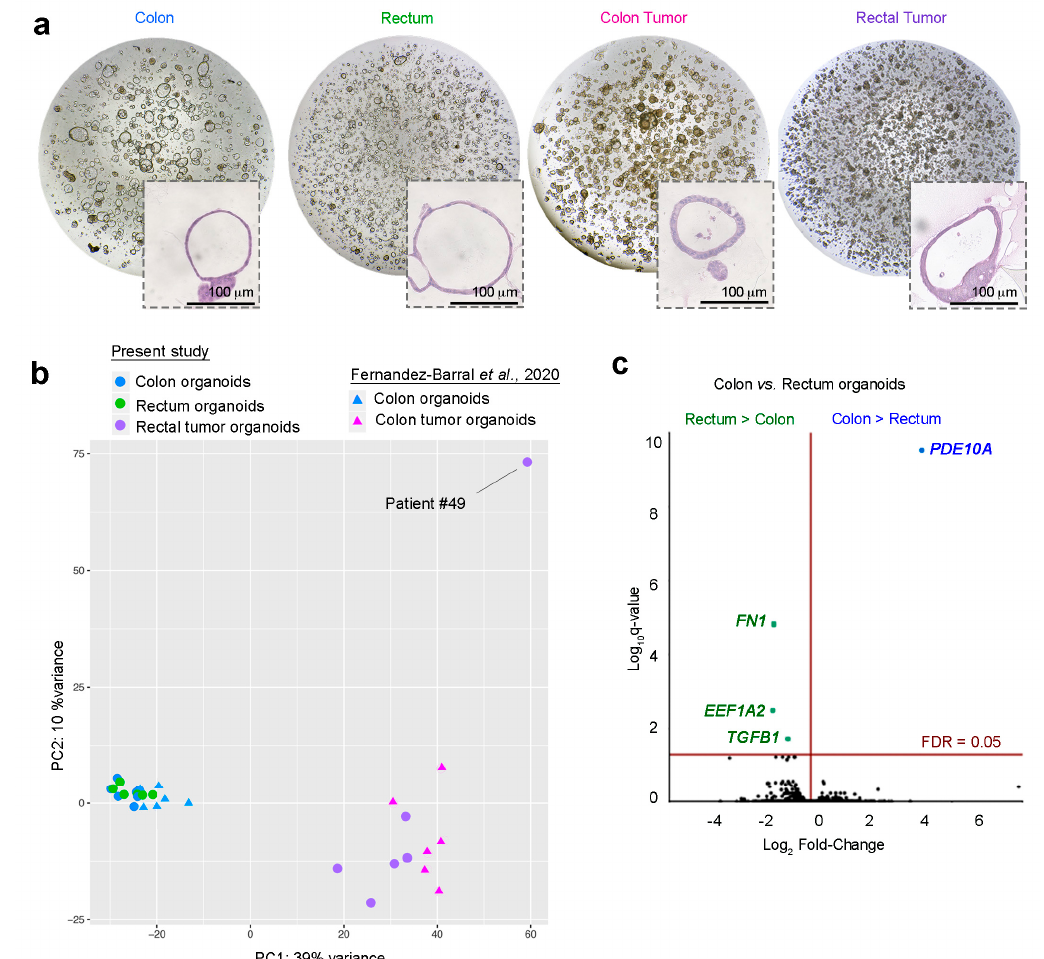
Figure 1. Morphology and gene expression analysis of patient-derived normal and tumoral colon and rectum tissues. ( a ) Phase-contrast micrographs of each type of patient-derived organoid culture. Insets show hematoxylin and eosin (H&E) staining. Scale bar = 100 μ m. ( b ) Principal component analysis (PCA) plot of the transcriptomes of organoid cultures derived from the colon, rectum, rectal tumor, and colon tumor. Additional RNA-seq data for normal and tumor colon organoids were included from a previous publication (accession number GSE100785) [33]. ( c ) Volcano plot comparing human colon and rectum RNA-seq signatures from six matched normal organoid cultures. The x -axis shows Log 2 fold-change (Log 2 FC) and the y -axis shows the q -value ( − Log 10 ).